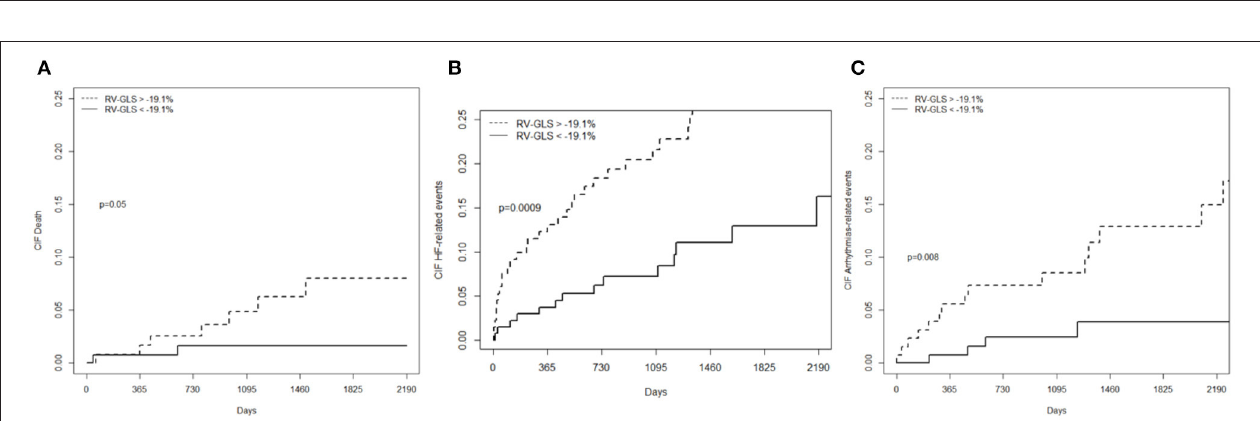
FIGURE 4 | Kaplan-Meier curves. The association of RV-GLS > − 19% and LGE were strongly associated to MACEs in NICM patients. Blue curve shows survival in patients without LGE and with preserved RV-GLS; yellow curve shows survival in patients without LGE and with reduced RV-GLS; green curve shows survival in patients with LGE and preserved LV-GLS; purple curve shows survival in patients with LGE and reduced RV-GLS. LGE, late gadolinium enhancement; RV-GLS, right ventricular global longitudinal strain; MACEs, major cardiovascular events.